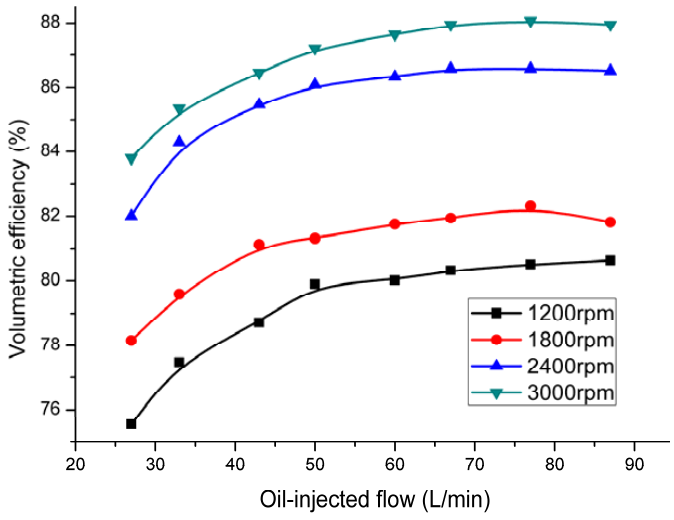
Figure 6. Variation of volumetric efficiency under different oil flow rates.